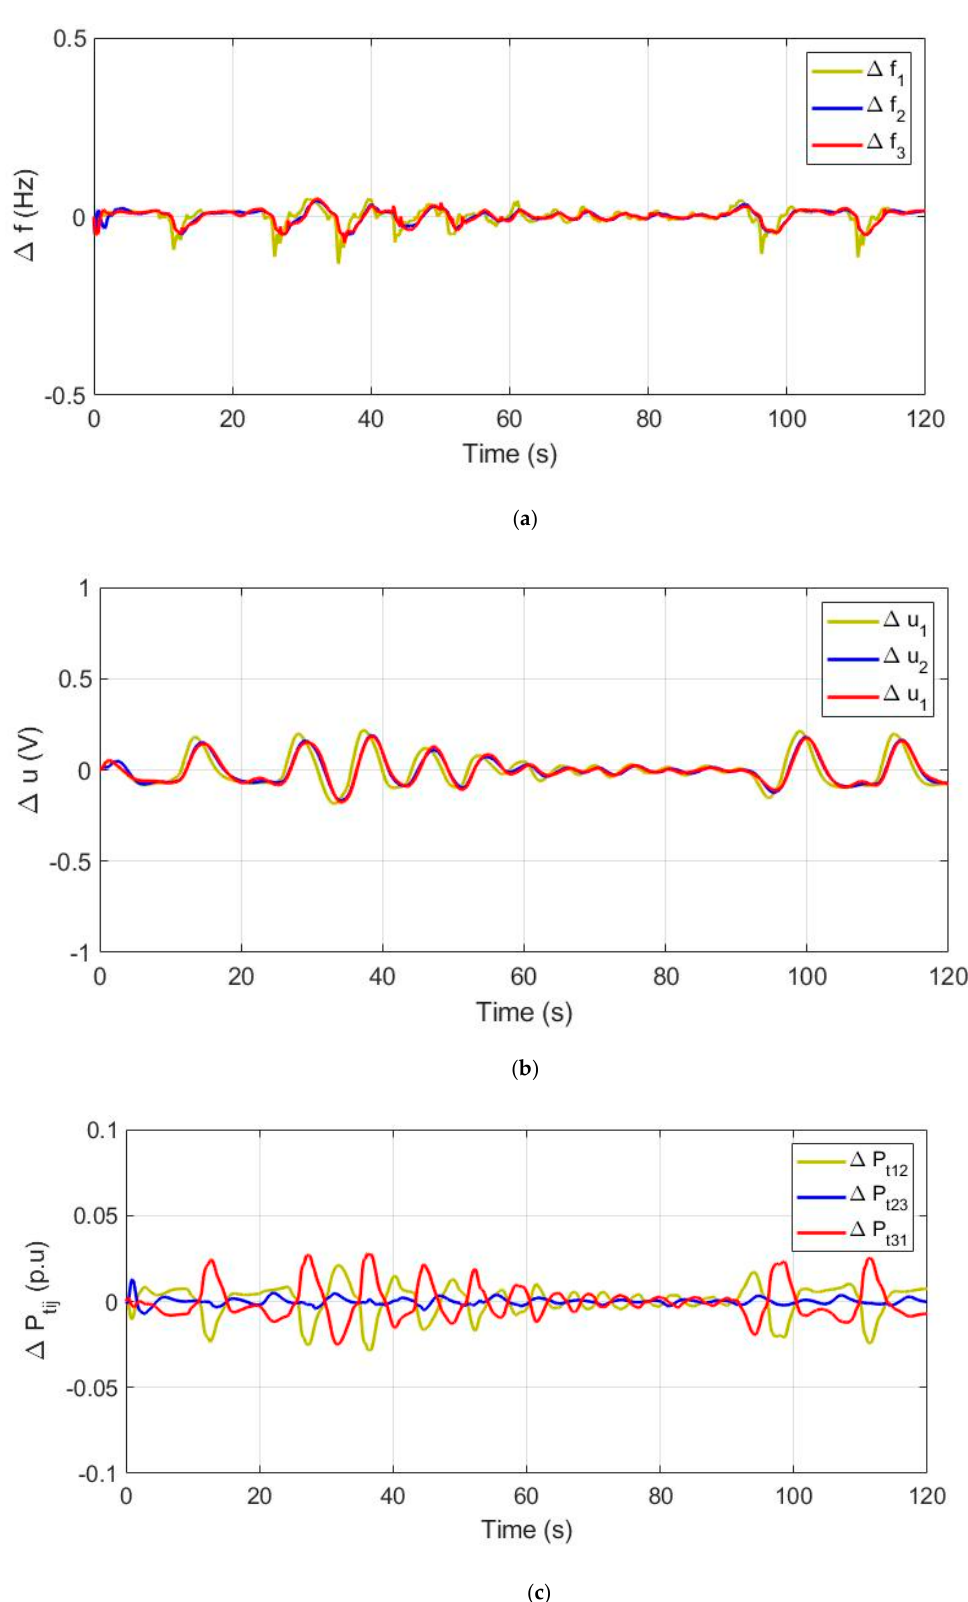
Figure 9. Case 1: ( a ) frequencies ( ∆ f i ), ( b ) voltages ( ∆ u i ), and ( c ) ∆ P tij